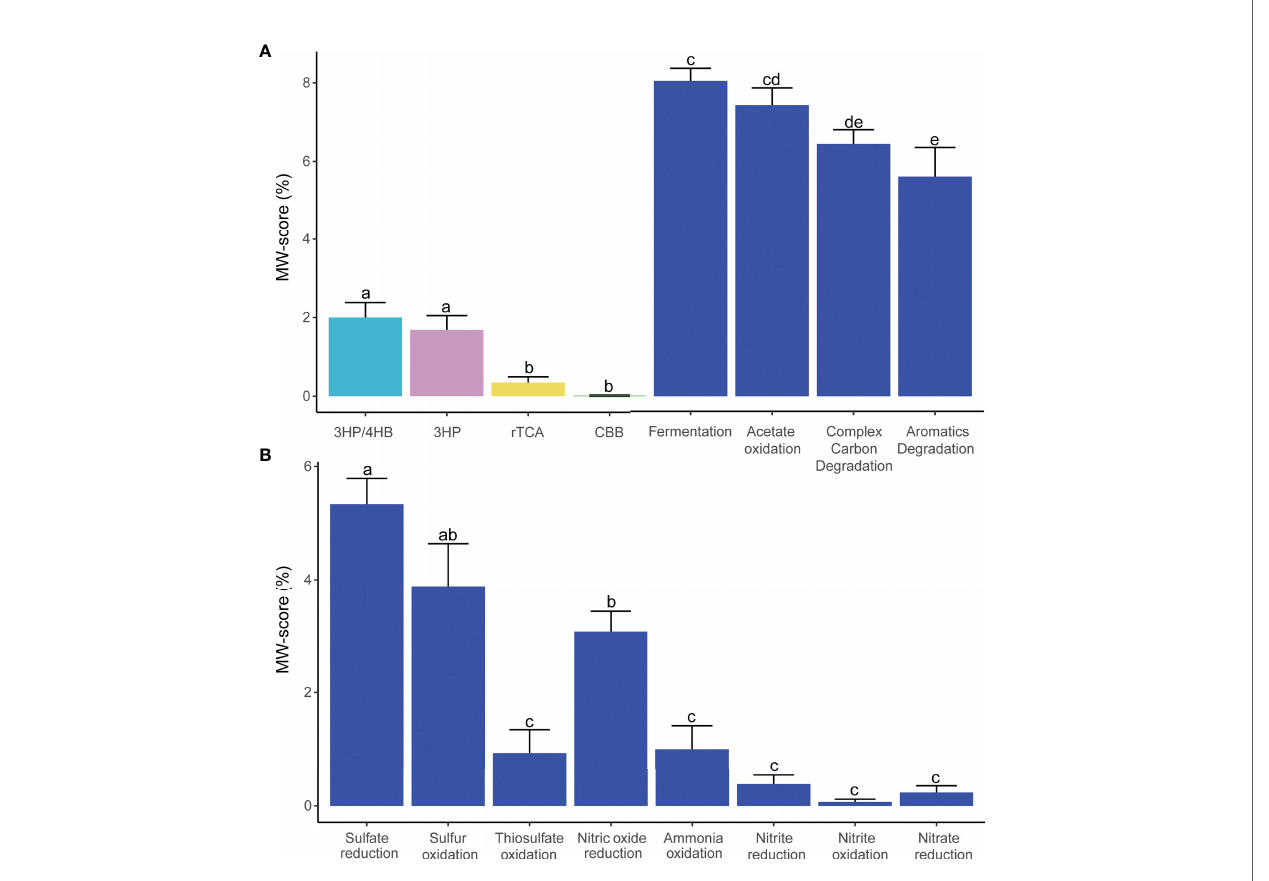
FIGURE 3 | Microbiome metabolism pro fi le based on metabolic weight score (MW-score). (A) Comparison between autotrophic and heterotrophic metabolisms. Autotrophic: 3-Hydroxypropionate/4-hydroxybutyrate (3HP/4HB), 3-Hydroxypropionate bicycle (3HP), Reductive tricarboxylic acid (rTCA), and Calvin – Benson – Bassham cycle (CBB); Heterotrophic: Fermentation, Acetate oxidation, Complex carbon degradation, and Aromatics degradation. (B) Comparison between sulfur and nitrogen metabolism. Bars with different letters indicate statistical differences at P < 0.05; those with the same letters indicate no statistical